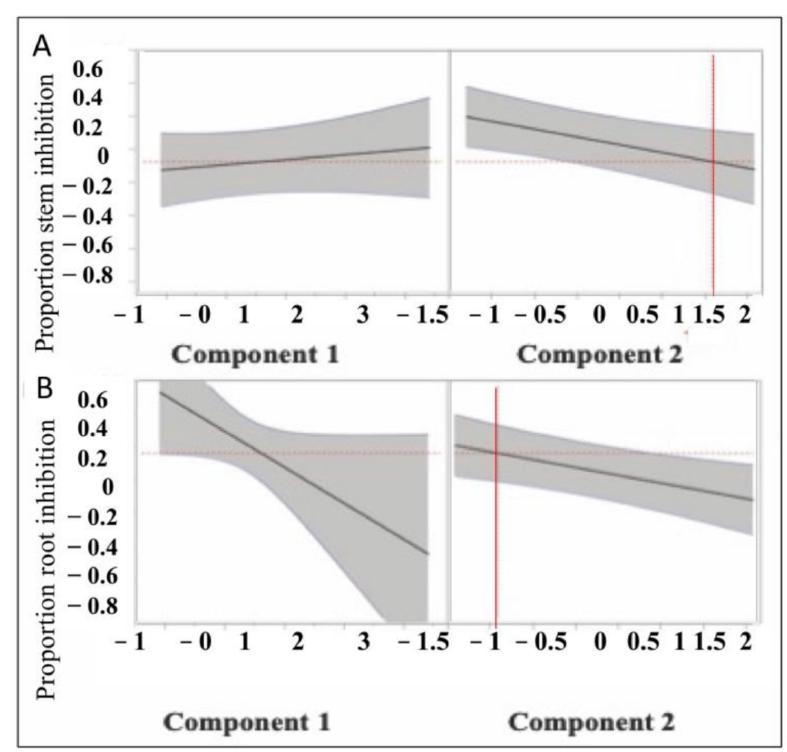
Figure 9. Prediction profiles for the effects of metal factor 1 and metal factor 2 on root inhibition. ( A ) Profile when metal component 2 is set to 1.5, and ( B ) profile when metal component 2 is set to − 1.0 (high Hg and low